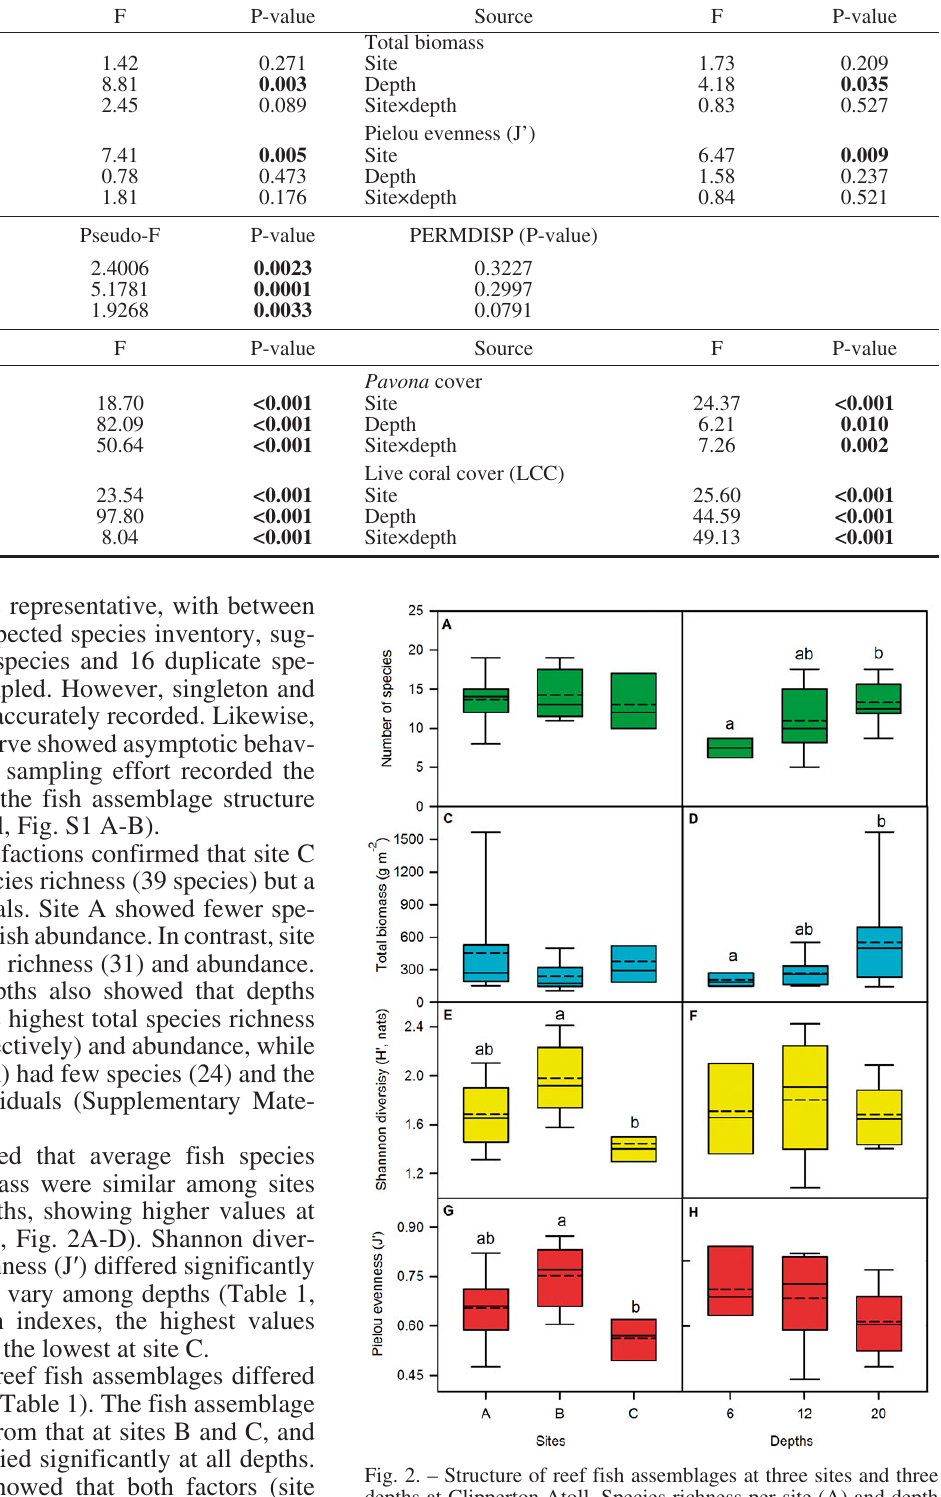
Table 1. – Statistical results of two-way ANOVA for species richness, biomass, diversity indexes and coral cover (i.e. total live coral cover, Pocillopora , Porites and Pavona ) among sites and depths at Clipperton Atoll. The outcomes of the PERMANOVA and PERMDISP are presented, which compare the species composition of fish assemblages among sites across depths.